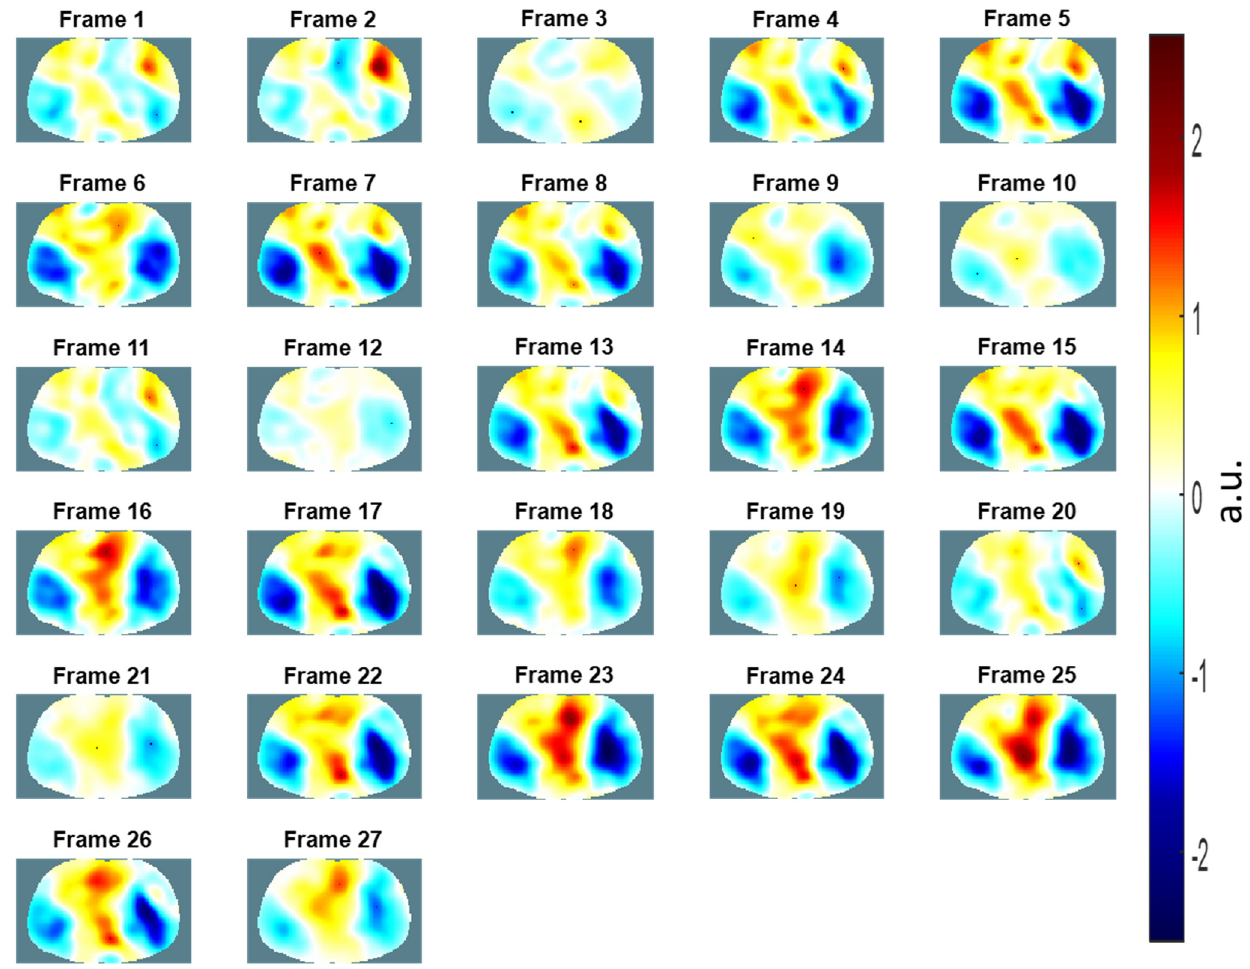
Figure 12. The electrical impedance tomography images of the chest over three breathing cycles using the wearable textile-electrode belt.